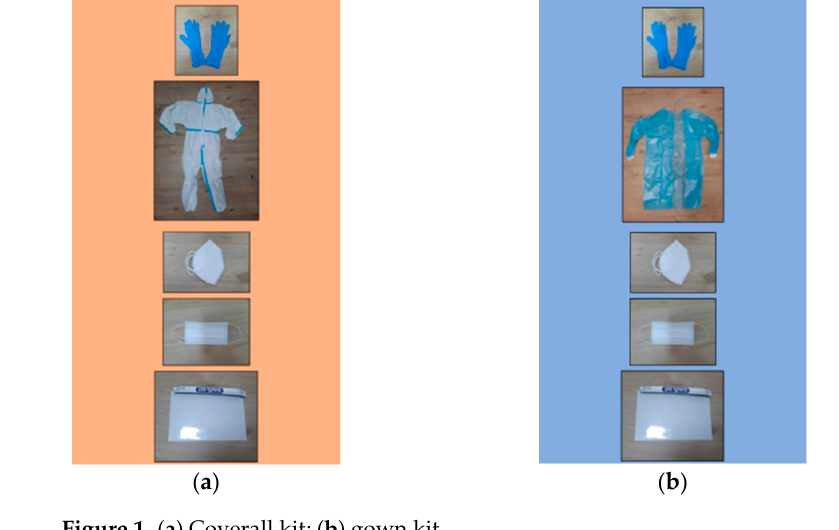
Figure 1. ( a ) Coverall kit; ( b ) gown kit